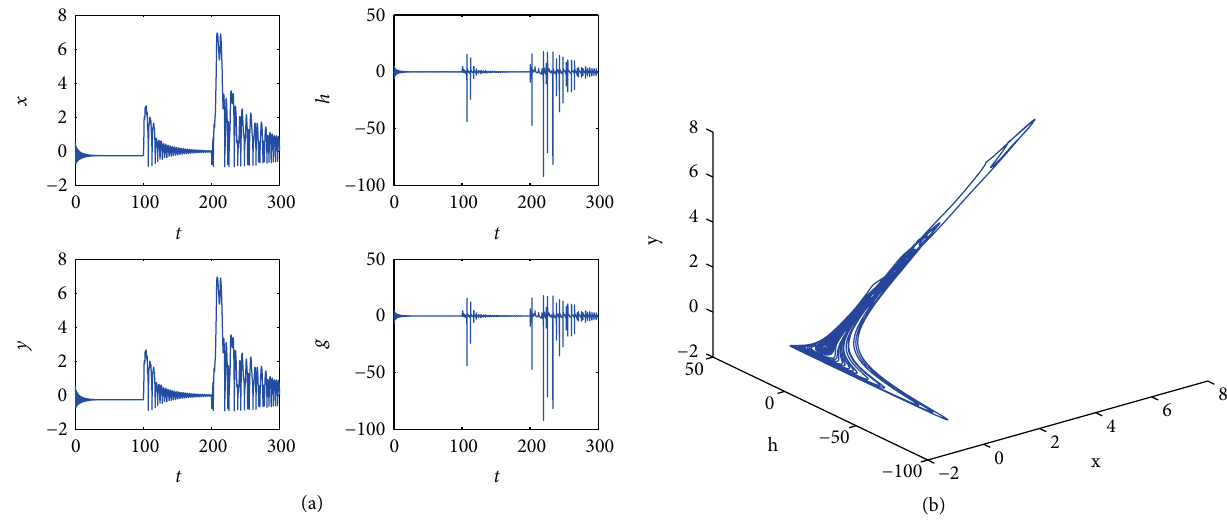
Figure 7: Simulated solution of Equation (2) for 𝑃 = 1000, 𝑟 = 4/3,𝑐 = 94,𝜏 = 100 : showing the chaotic